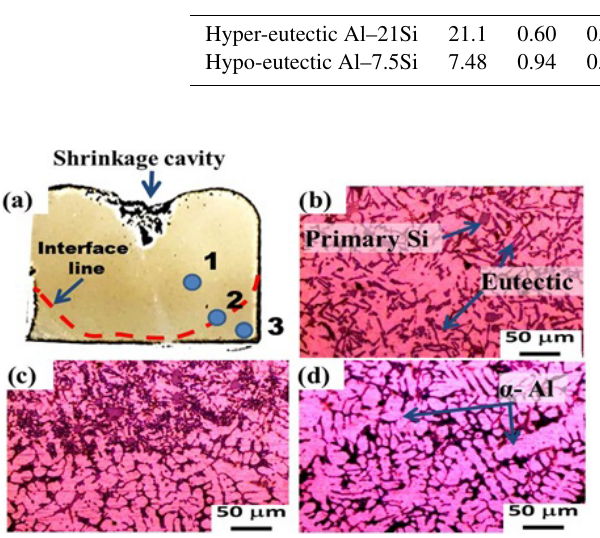
Figure 3. Macro- and microstructure of bimetal casting for a 10s time interval. (a) Macrophotograph cross section. (b, c, d) Repre- sentation of the microstructures of points 1, 2 and 3, respectively.